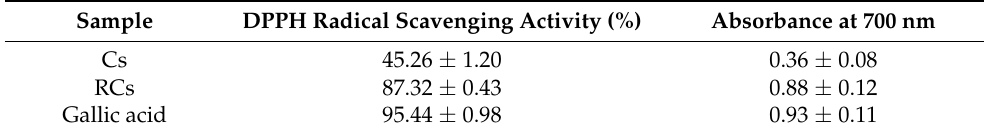
Table 5. Antioxidant activity of the Cs and